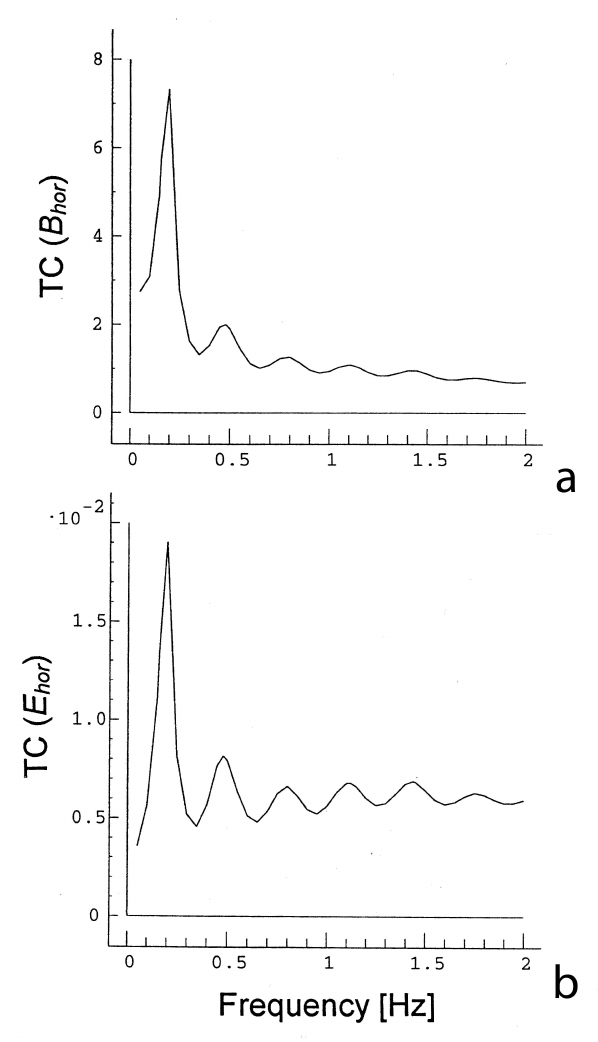
Fig. 3. The transmission coefficient of the left-handed field-aligned Alfv´enic (L || ) wave horizontal magnetic (a) and electric (b) field at 10:30 UT. The model ionosphere extends up to